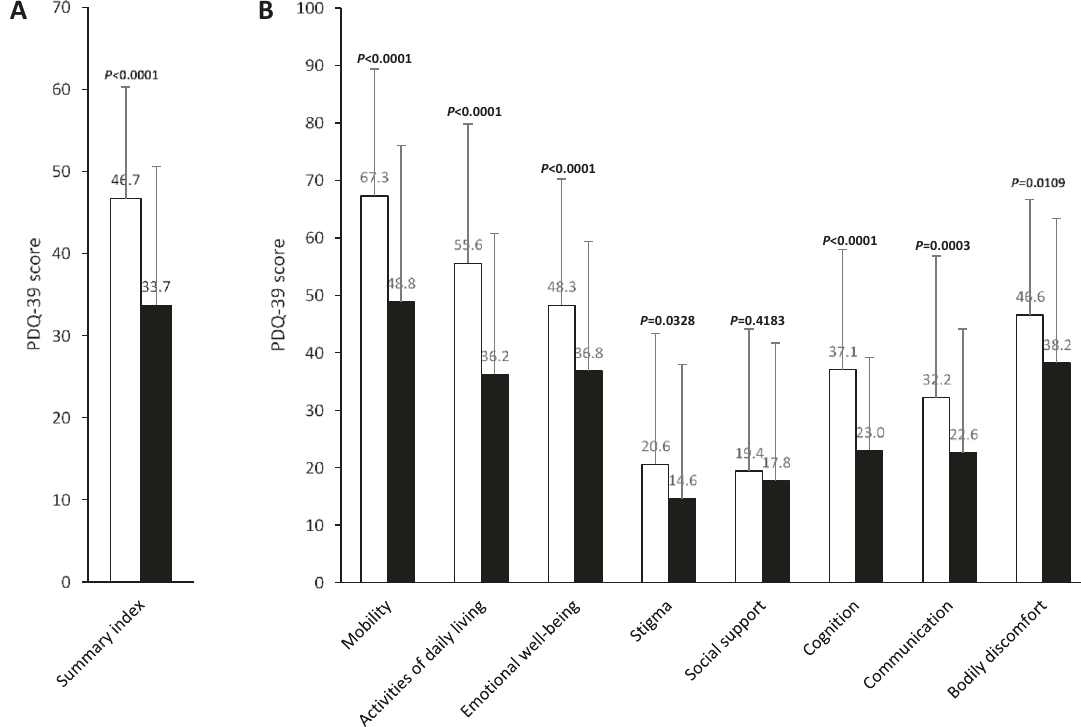
Fig. 1 PDQ-39, 39-item Parkinson ’ s Disease Questionnaire. A Summary index. B Domain scores. White bars: data at baseline, black bars: data at fi nal visit. P values for PDQ-39 score comparison between fi nal visit and baseline. Values are given as mean ± SD.